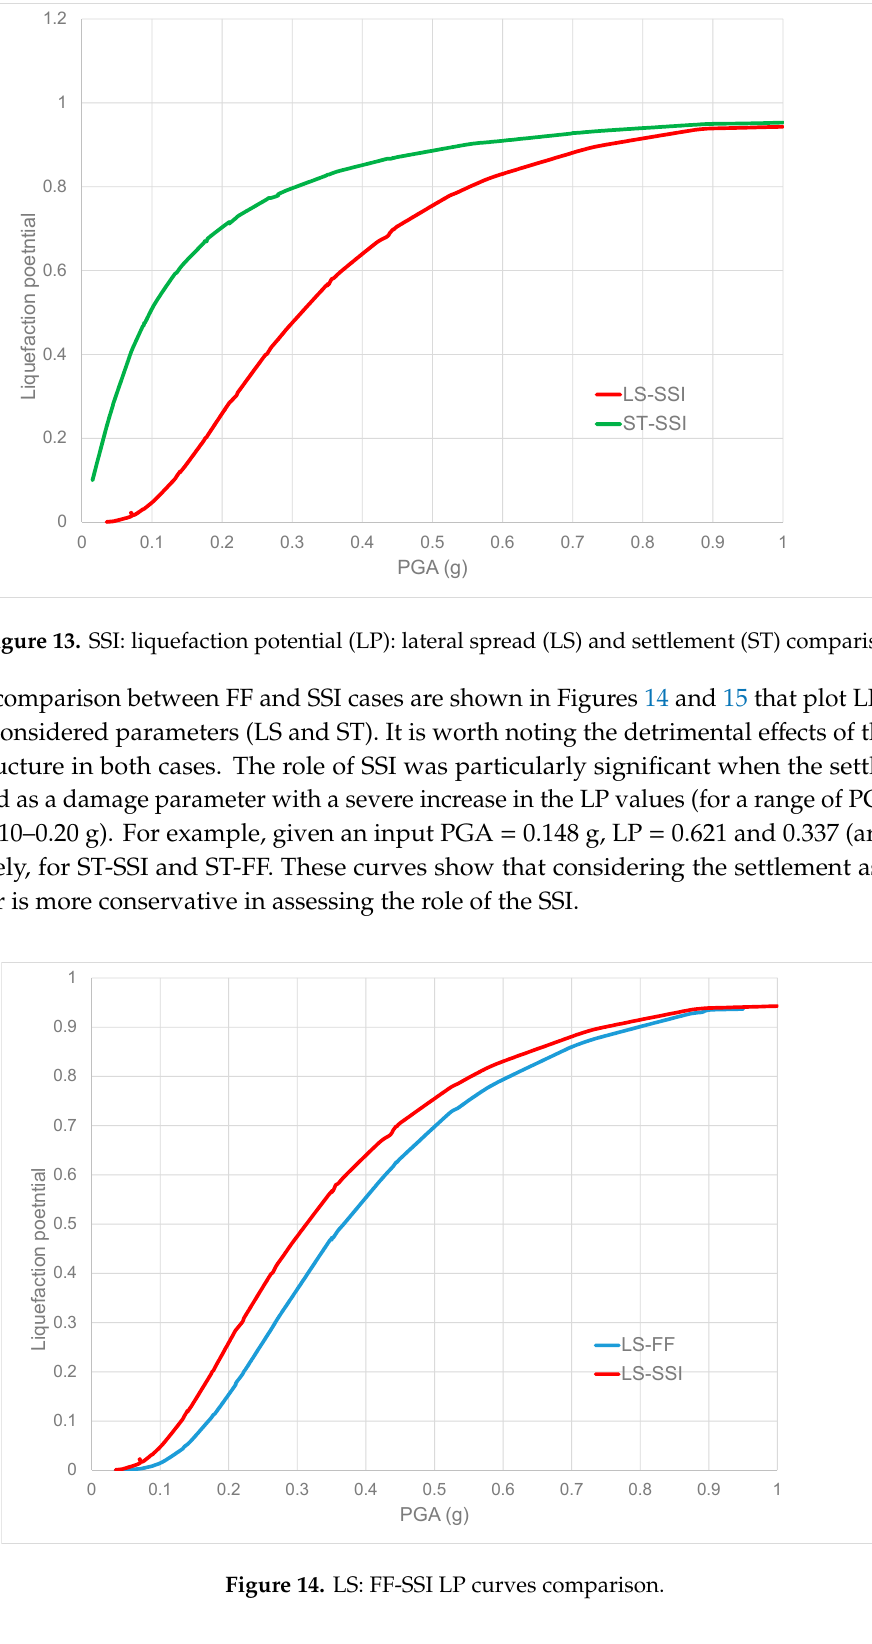
Figure 14. LS: FF-SSI LP curves comparison.